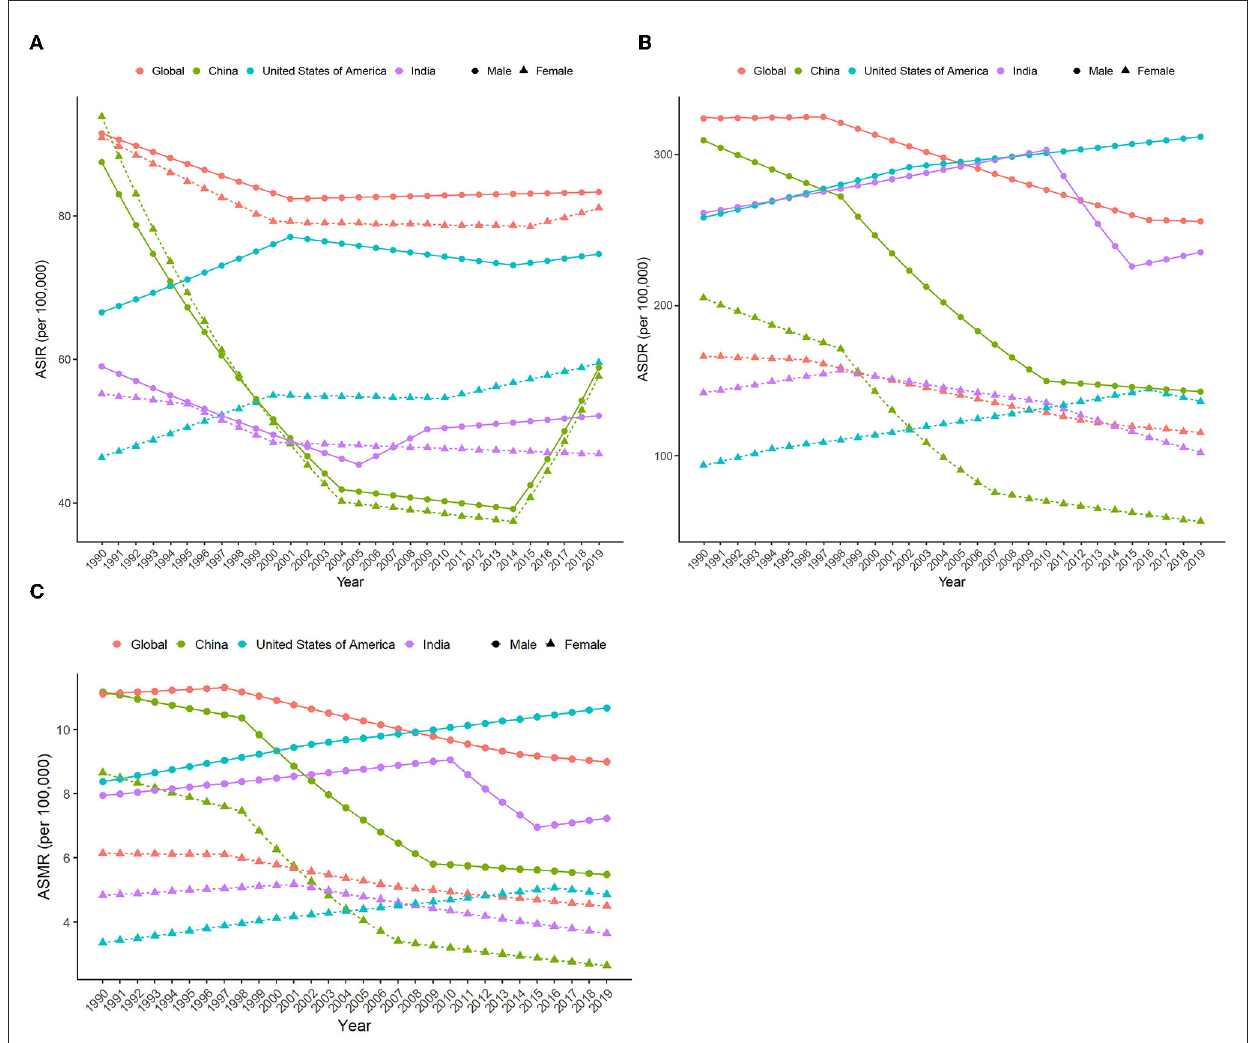
FIGURE5 APC in ASIR, ASDR, and ASMR (per 100,000) due to HCV from 1990 to 2019 by sex in different regions. (A) ASIR; (B) ASDR; (C) ASMR. APC, annual percent change; ASIR, age-standardized incidence rate; ASDR, age-standardized DALY rate.